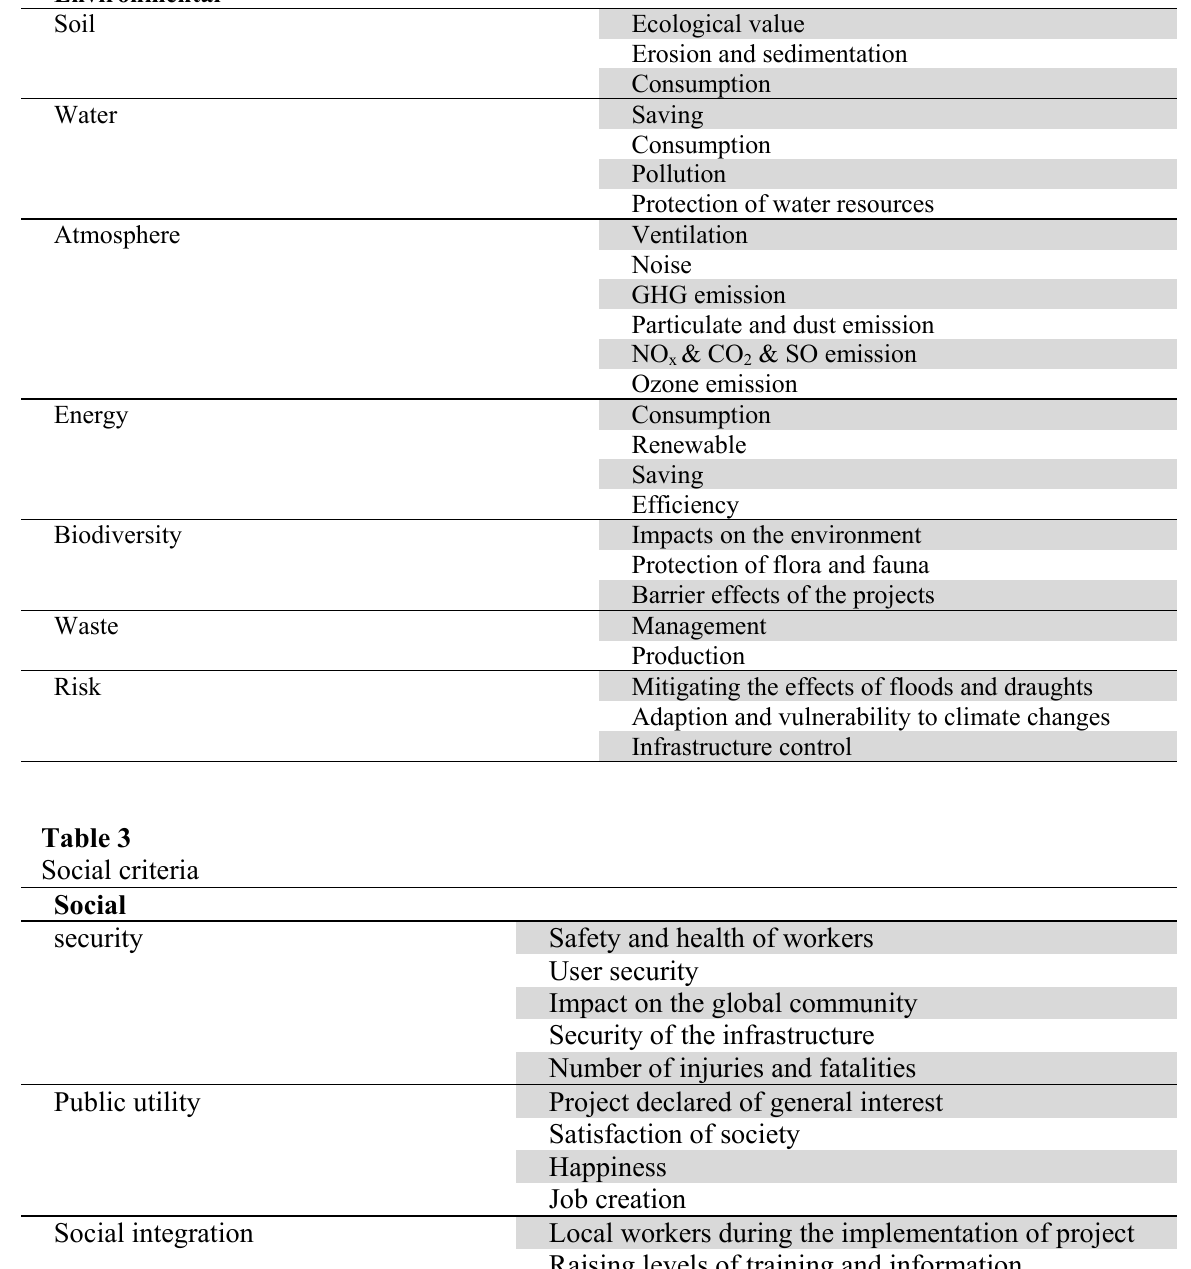
Environmental criteria